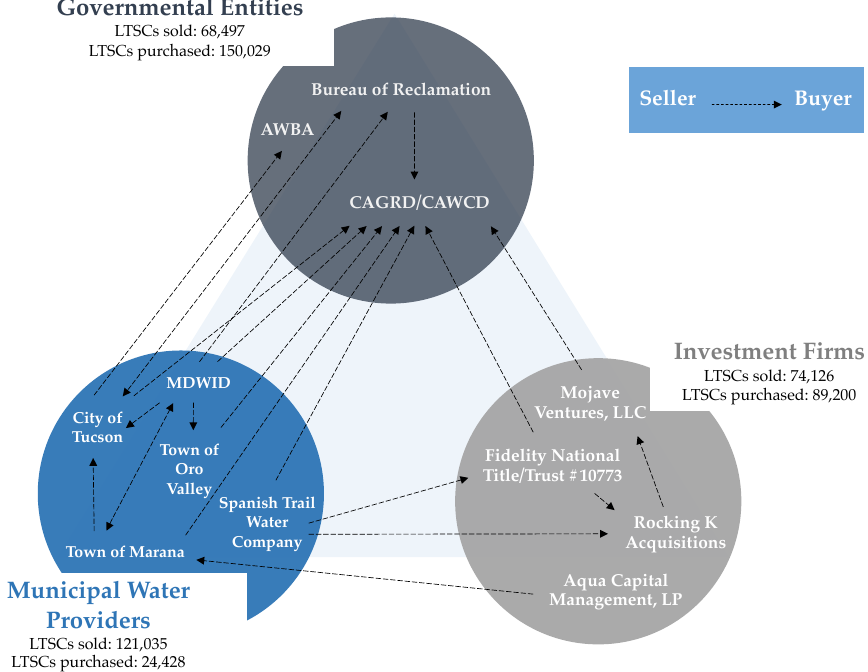
Figure 5. Direction of sales and purchases, and amount of long-term storage credits traded between governmental entities, municipal water providers, and investment firms, from 1994 to 2016 in the Tucson